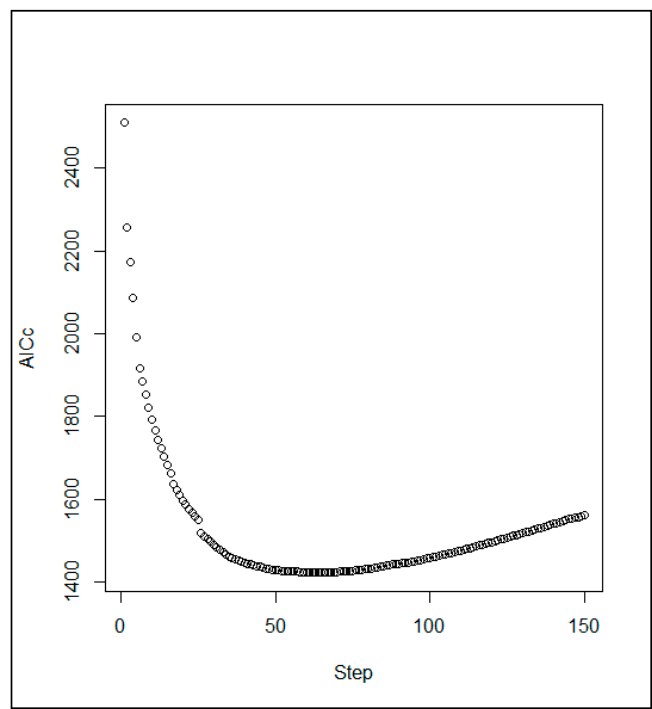
Figure 3. Stepwise-ordinary least squares (SW-OLS) Akaike Information Criterion (AICc) performance.